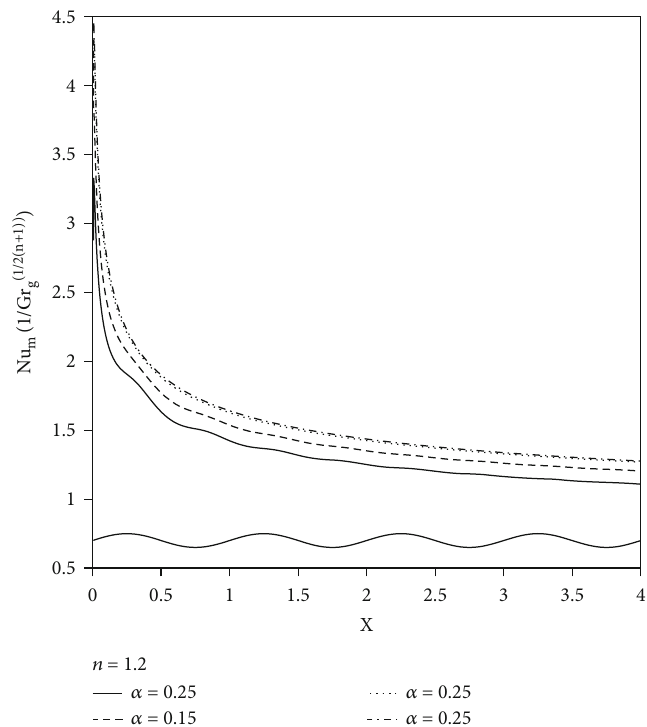
Figure 11: The axial distribution of the mean Nusselt number for Pr